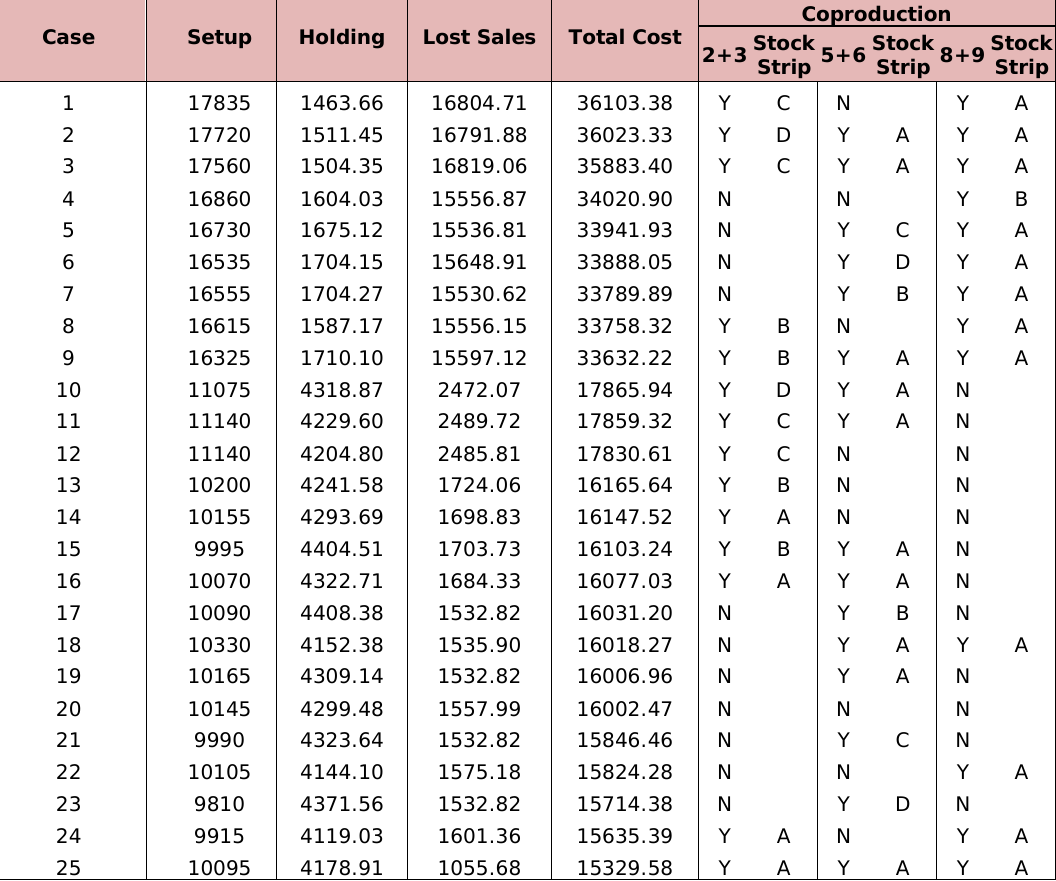
Table 6. “Costs for different cases of coproduction by applying Fransoo modified